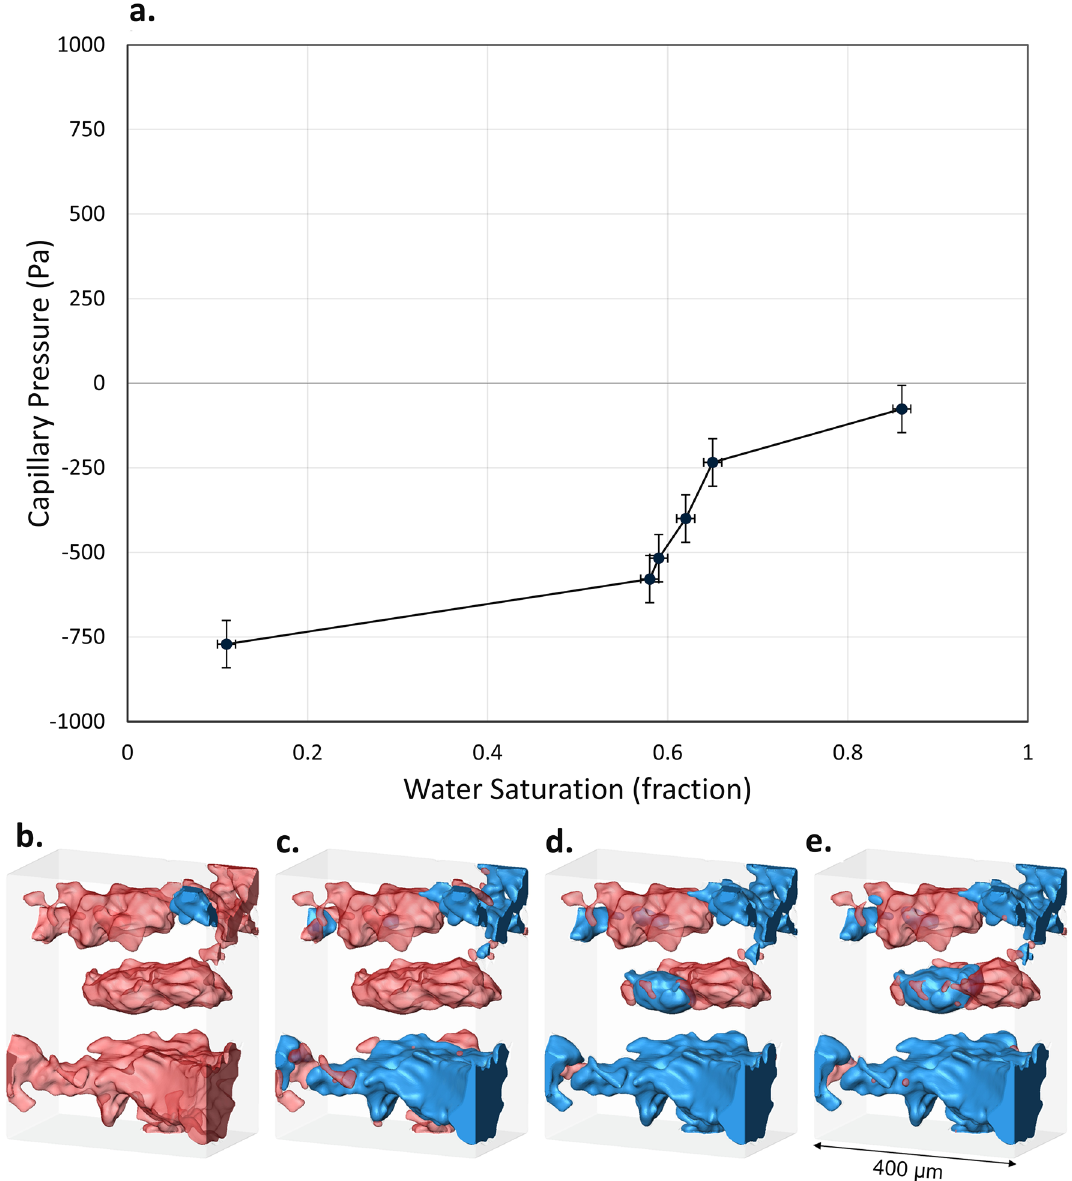
Figure 6. ( a ) The capillary pressure values estimated from the mean interfacial curvature, Fig. 5e, as a function of water (brine) saturation. ( b–e ) A 3D representation of the pore filling sequence during LSW where light grey, red and blue represent the rock, oil and brine phases, respectively. ( b ) Initially, pores were mainly filled with oil. ( c ) When waterflooding started, low salinity brine invaded large pores first with the lowest threshold capillary pressure. ( d,e ) Brine subsequently invaded smaller pores as more pore volumes were injected at higher flow rates. The pores and fluids were visualized using Avizo 9.5 sofware (https:// www. fei. com/ softw are/ amira-